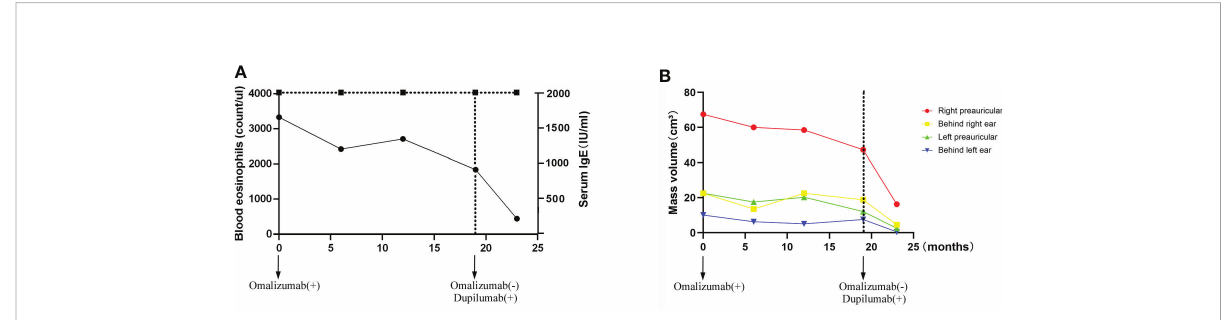
FIGURE 4 Time-course changes in the levels of eosinophil count and serum IgE (A) ; the change in mass volume in each region during treatment (B) .